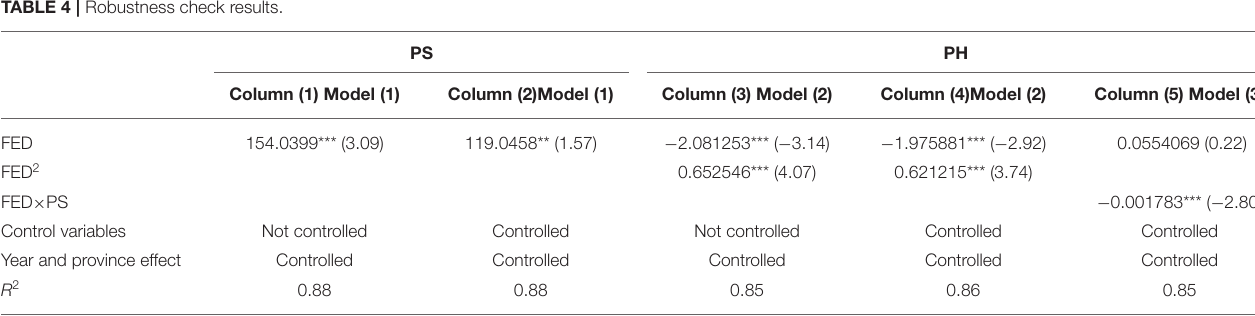
TABLE 4 | Robustness check